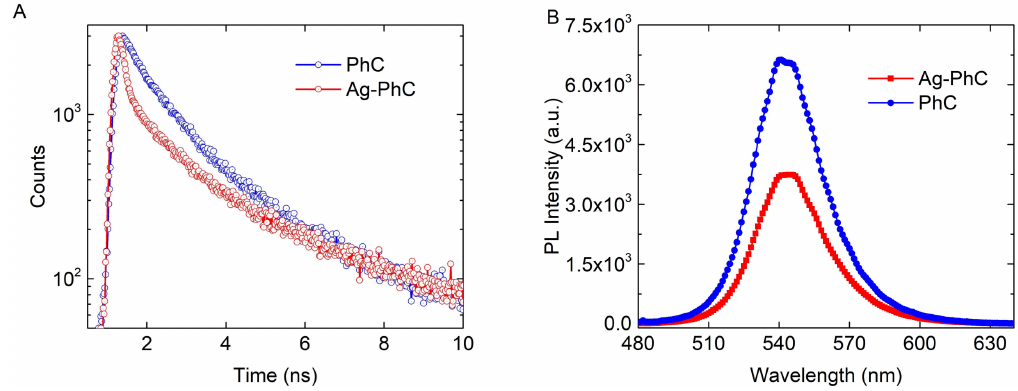
Figure 2. ( A ) Time-resolved photoluminescence (TRPL) and ( B ) PL spectra for Ag–PhC and PhC